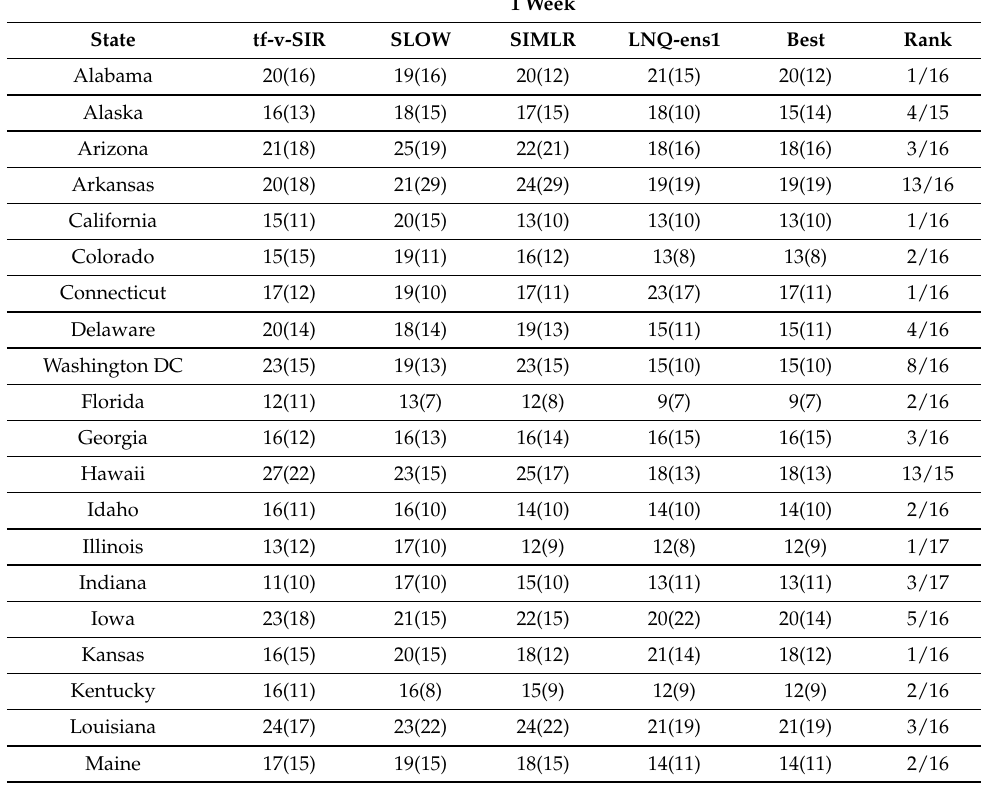
Table A1. Comparison of MAPE between different models across all the states in the US 1 week in advance. The number in parenthesis represents the standard deviation of the